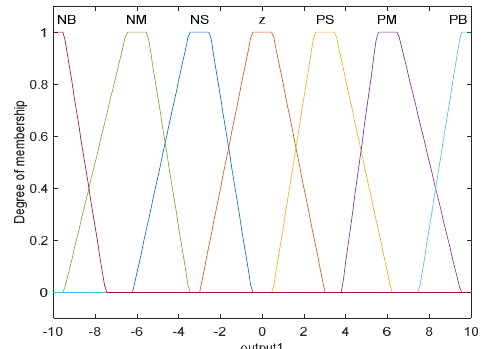
Fig. 5. The membership function of the output variables.